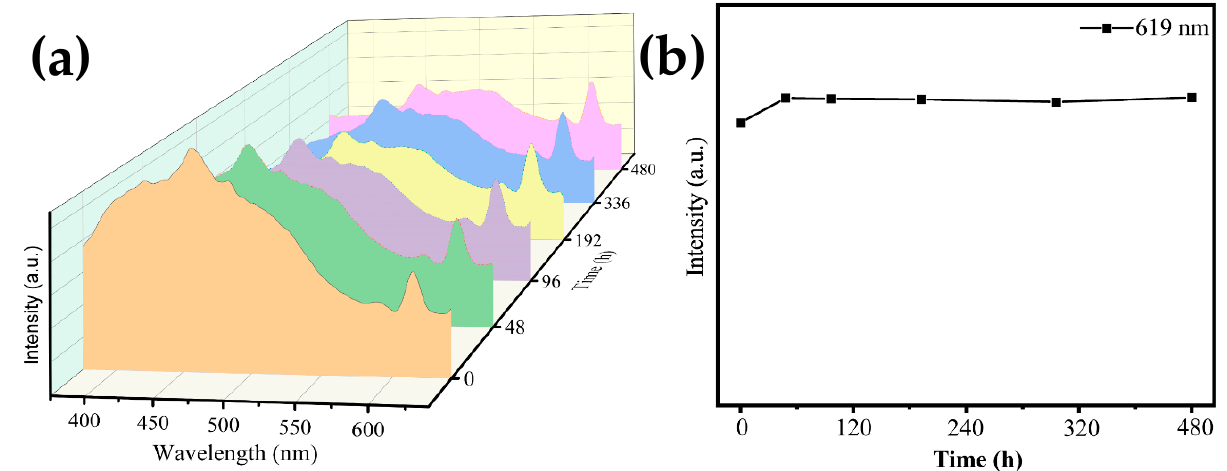
Figure 6. ( a ) Emission spectra of coating composite during the radiation of UV-light for different time (0 h, 48 h, 96 h, 192 h, 336 h, 480 h) and ( b ) variation tendency of emission intensity (614 nm). Table 2. The ratio of 5 D 0 → 7 F 2 / 5 D 0 → 7 F 1 under different time radiation. Radiation Time